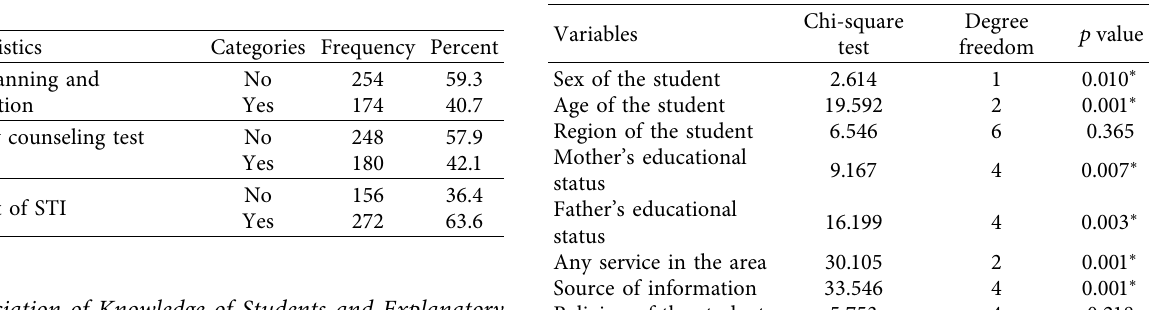
Table 5: Association of knowledge of YFHS among students and explanatory